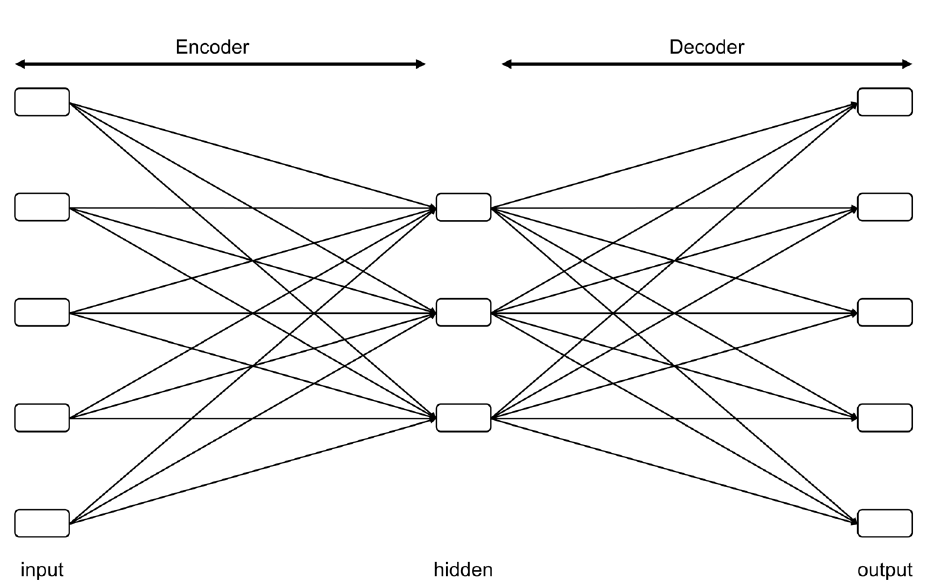
Figure 2. Autoencoder